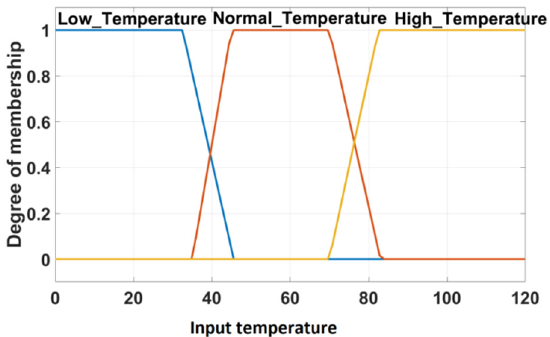
Figure 9 . Example of an input membership function for temperature control. Figure 9. Example of an input membership function for temperature